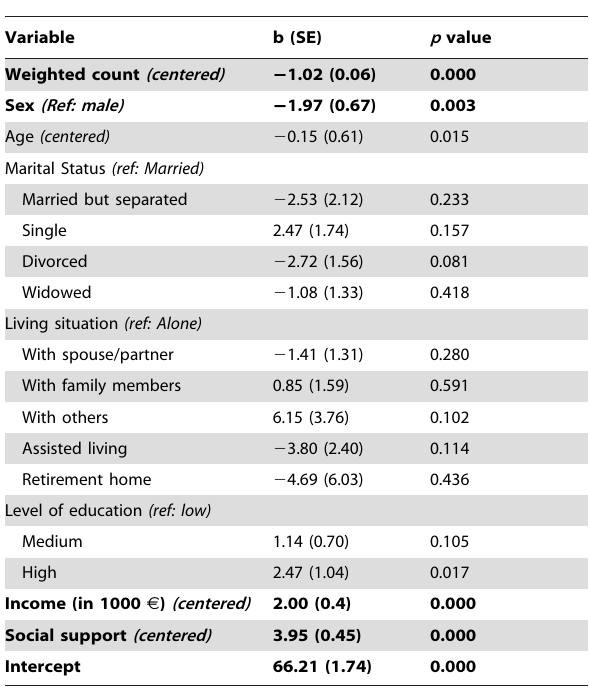
Table 4. Regression model of the effect of multimorbidity (weighted count score) on overall HRQL measured by the EQ